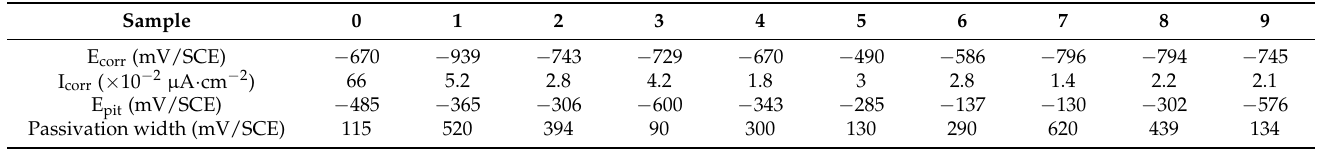
Table 3. Corrosion electrochemical parameters of the different